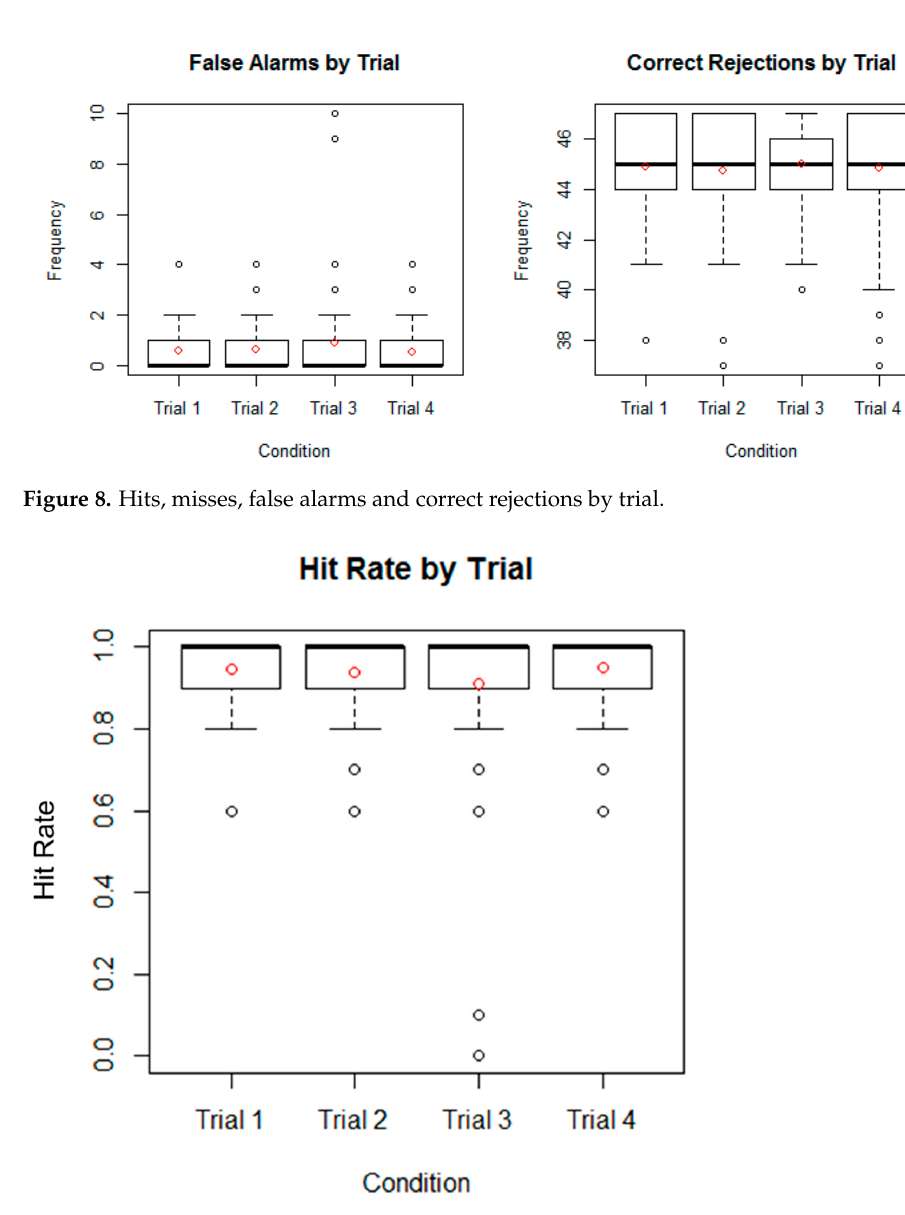
Figure 10. False alarm rate by trial.